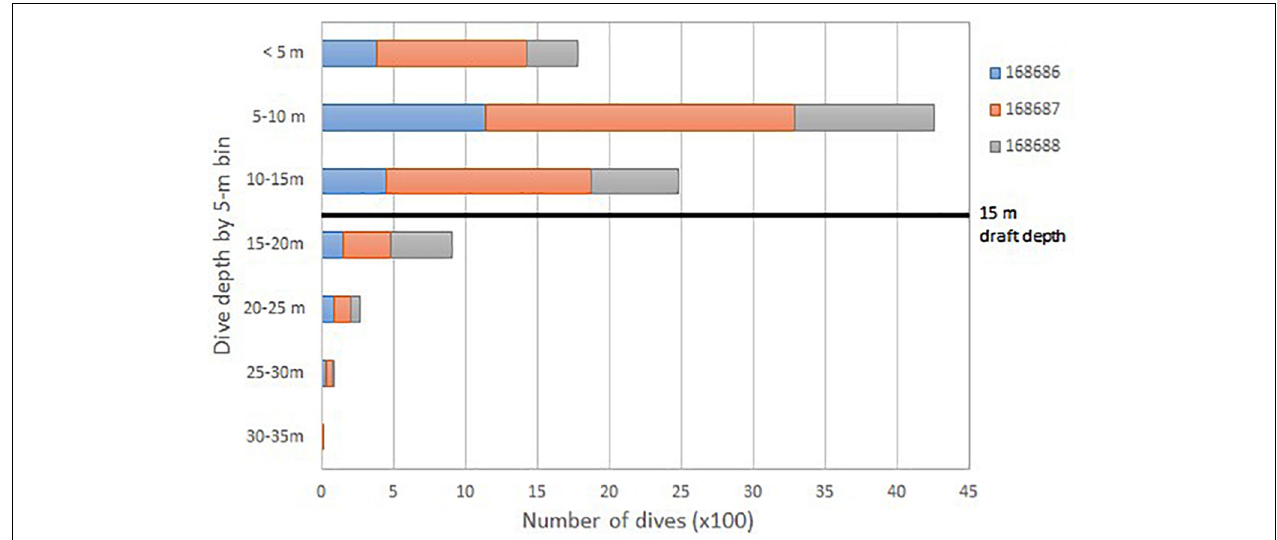
FIGURE 6 | Total number of dives (100 × ) for three satellite-tagged humpback whales (identified by PTT ID) grouped by 5-m depth bins. Maximum large-ship draft is noted by the black line.